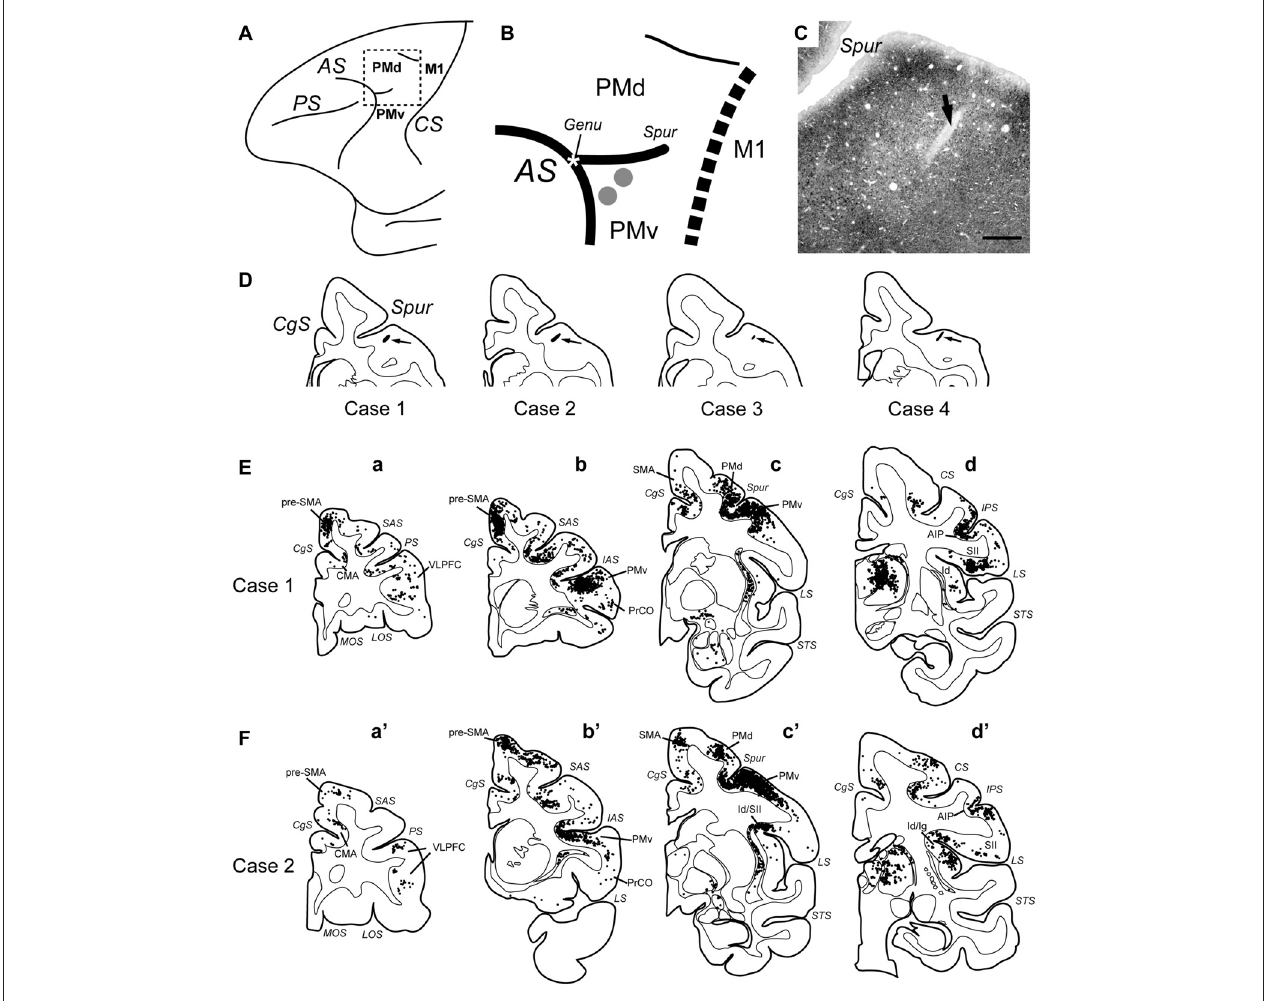
FIGURE 1 | (A) Schematic diagram showing the frontal lobe of the macaque monkey. The rectangular area demarcated with broken lines is enlarged in (B) . AS, arcuate sulcus; CS, central sulcus; M1, primary motor cortex; PMd, dorsal premotor cortex; PMv, ventral premotor cortex; PS, principal sulcus. (B) Sites of rabies injections in PMv. The estimated viral spread around each injection needle track is indicated with the gray circle (1 mm in diameter). The genu of AS (Genu) is denoted with the asterisk. The border between the premotor areas and M1 is drawn with the dotted line. Spur, spur of AS. (C) Photomicrograph of the injection site in Case 4. The arrow denotes the injection needle track. Scale bar, 1 mm. (D) Drawing of a representative coronal section through the injection needle track (pointed to by the arrow) in each case. CgS, cingulate sulcus. (E,F) Distributions of retrograde neuron labeling 3 days after the rabies injections into PMv in Case 1 (E) and Case 2 (F) . Only cortical labeling is depicted. In each case, four representative coronal sections are arranged rostrocaudally in (a–d) or (a (cid:48) –d (cid:48) ) . Each dot represents one labeled neuron. AIP, anterior intraparietal area; CMA, cingulate motor areas; Id, dysgranular insular cortex; Ig, granular Insular cortex; IAS, inferior limb of AS; IPS,